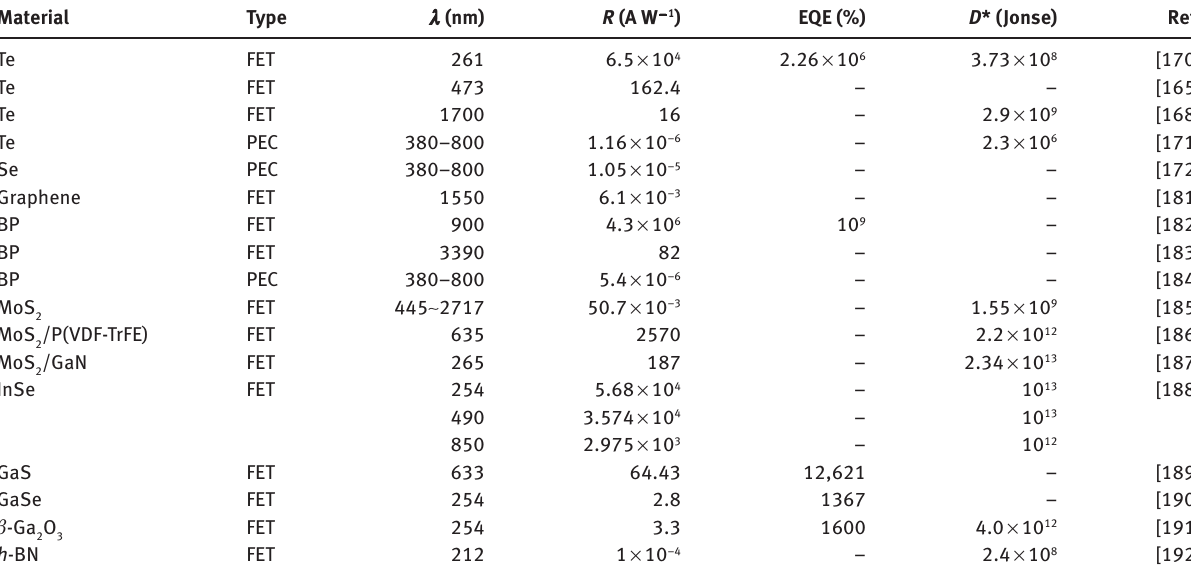
Table 2: The comparison of photodetectors based on the state-of-the-art 2D materials.